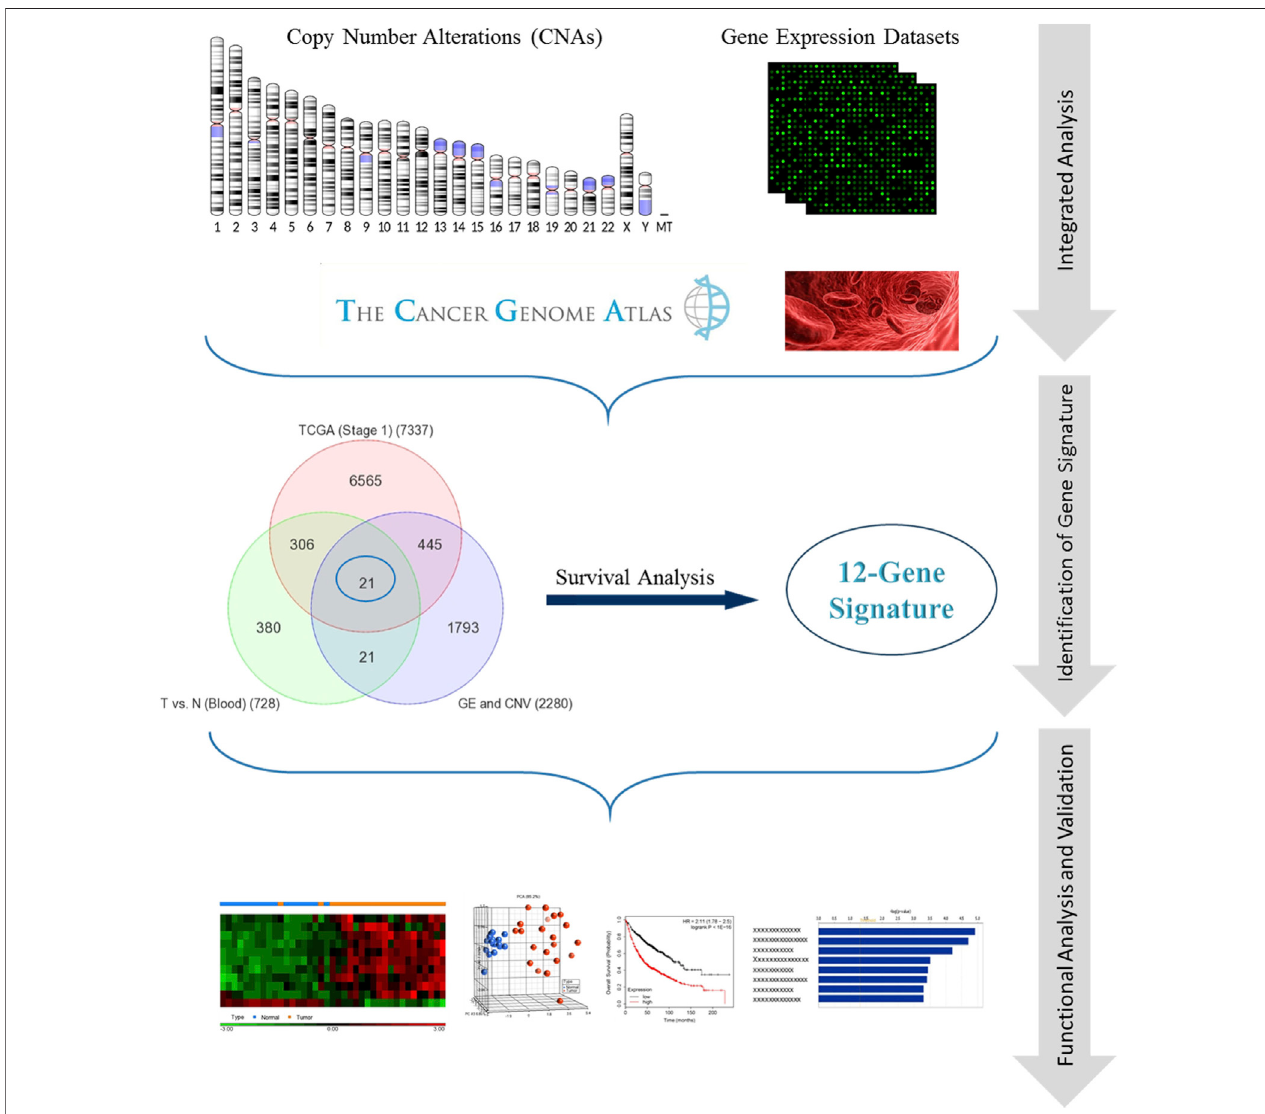
FIGURE 1 | Schematic fl owchart illustrating the